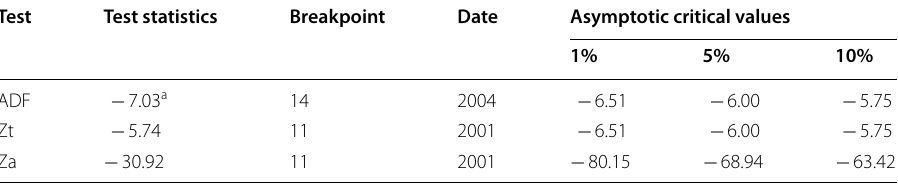
a Implies significant at 1%